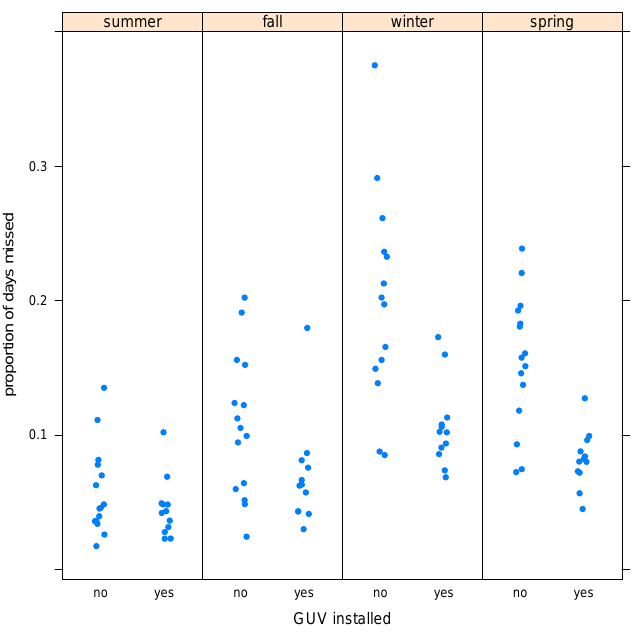
Figure 1. Monthly absenteeism rates, grouped by